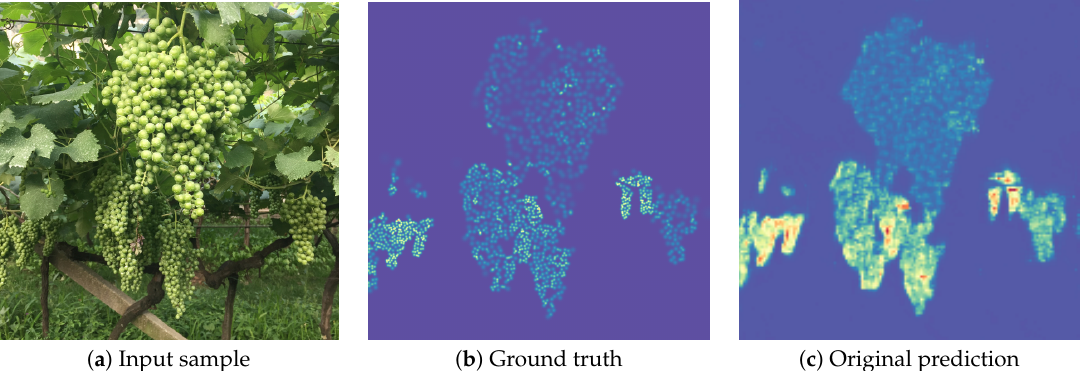
Figure 2. Example of application of CSRNet on a CR2 image ( a ), its associated ground truth ( b ) and model output ( c